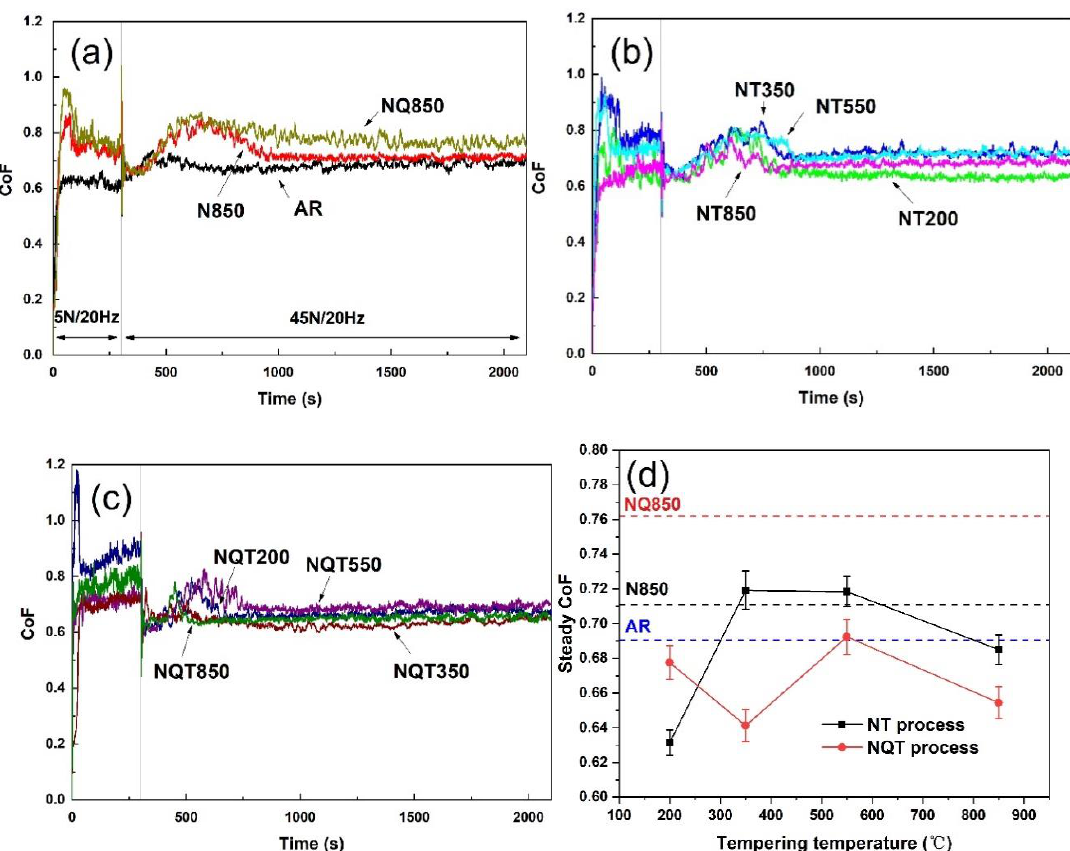
Figure 4. The fretting CoF of 25CrNi2MoVE steel under different tempering states: ( a ) under AR, N850 and NQ850 states, ( b ) under NT200, NT350, NT550 and NT850 states, ( c ) under NQT200, NQT350, NQT550 and NQT850 states, ( d ) steady CoF.